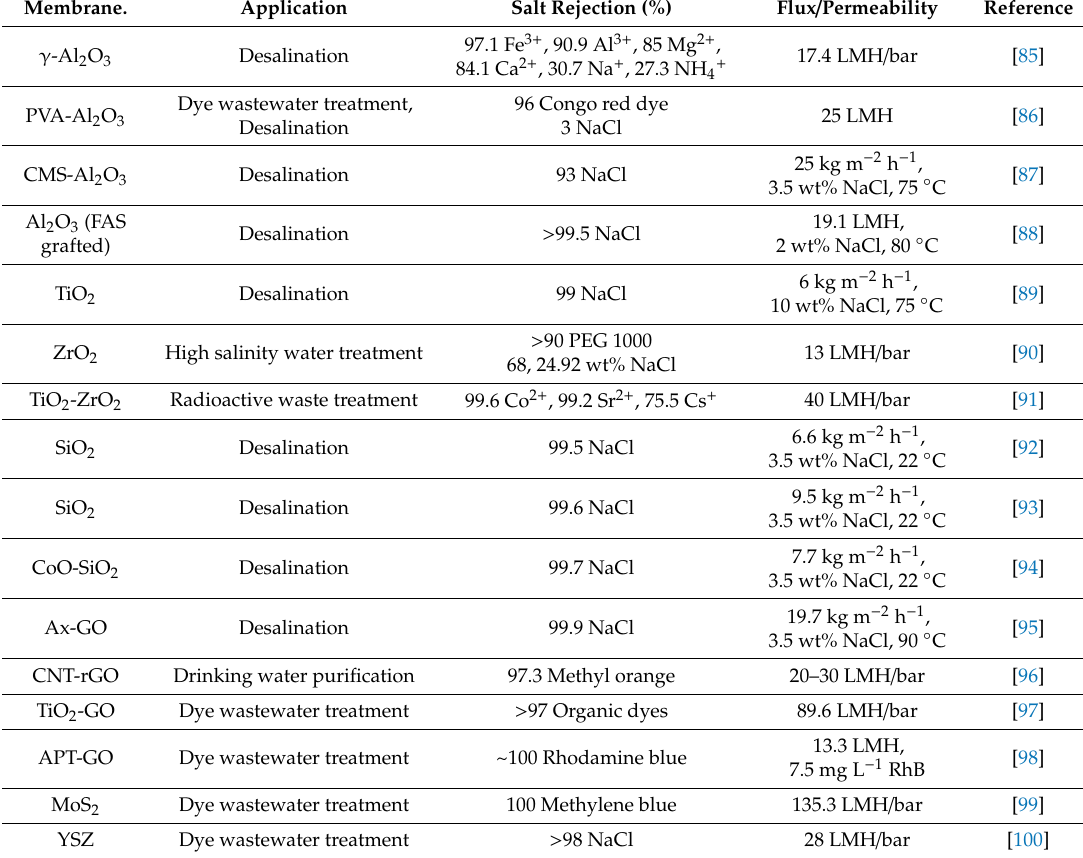
Table 4. State-of-the-art inorganic RO and NF membranes for water